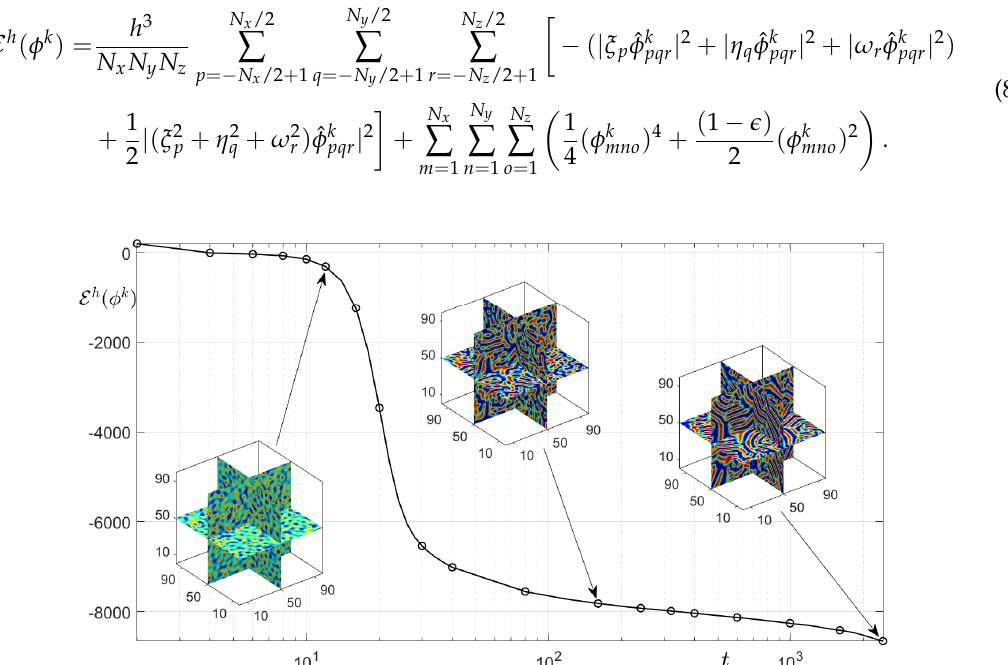
Figure 34. Energy dissipation over time of Equation (87) via SH equation with the initial condition (86) . Each snapshot depicts the evolution at t = 200 ∆ t , 4000 ∆ t , and 24,000 ∆ t , respectively. Note that t -axis is on